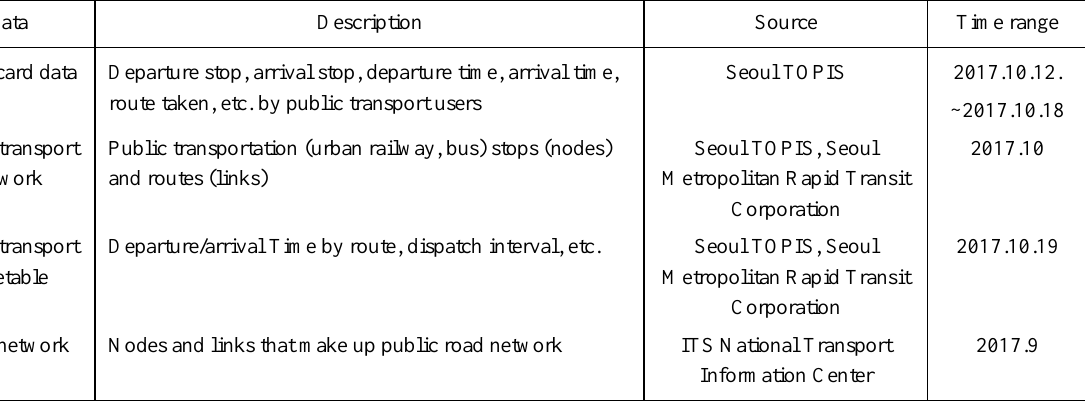
Table 1. Description and source of major